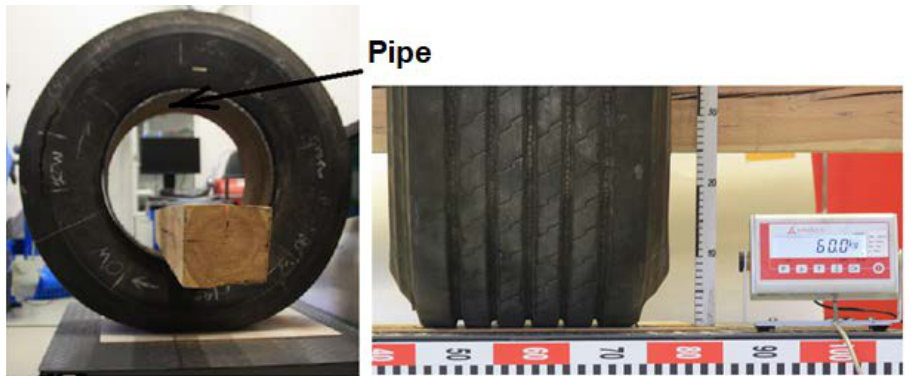
Figure 11. Method of loading the test tire and measuring the initial deflection of a tire loaded with a mass of 60 kg.